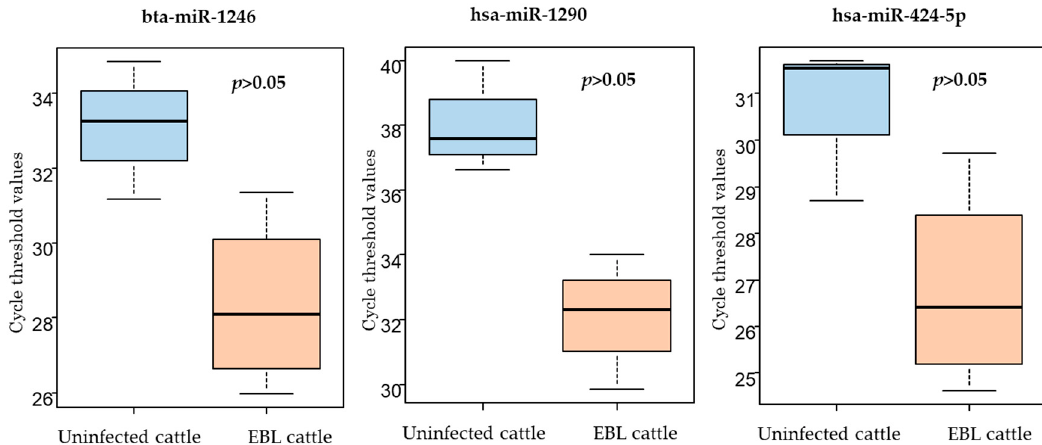
Figure 3. Cycle threshold (Ct) values for qPCR of the three selected miRNAs in milk small extracellular vesicles (sEVs) used in the microarray analysis. The levels of bta-miR-1246, hsa-miR-1290, and hsa-miR-424-5p were higher in milk sEVs from enzootic bovine leukosis (EBL) cattle ( n = 4) than in those from uninfected cattle ( n = 3). Mean of Ct values is shown as a horizontal bar in the boxes.